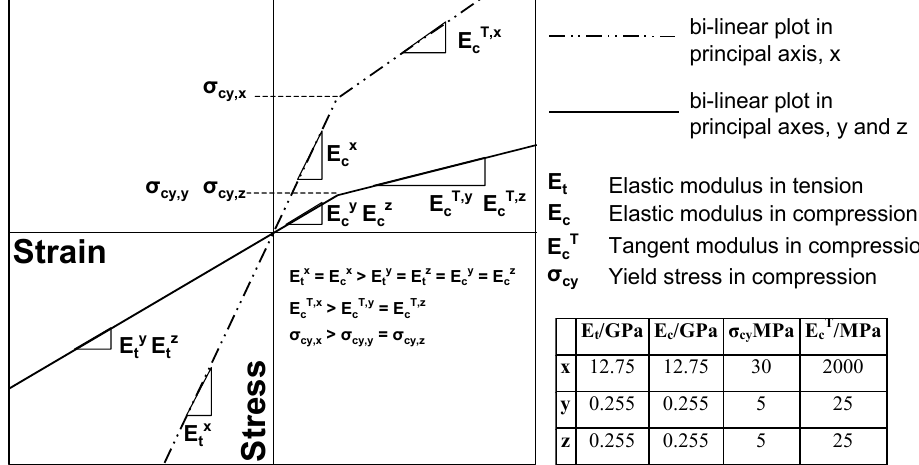
Figure 6. Stress-strain approximations and related values for LVL in each principal axis.